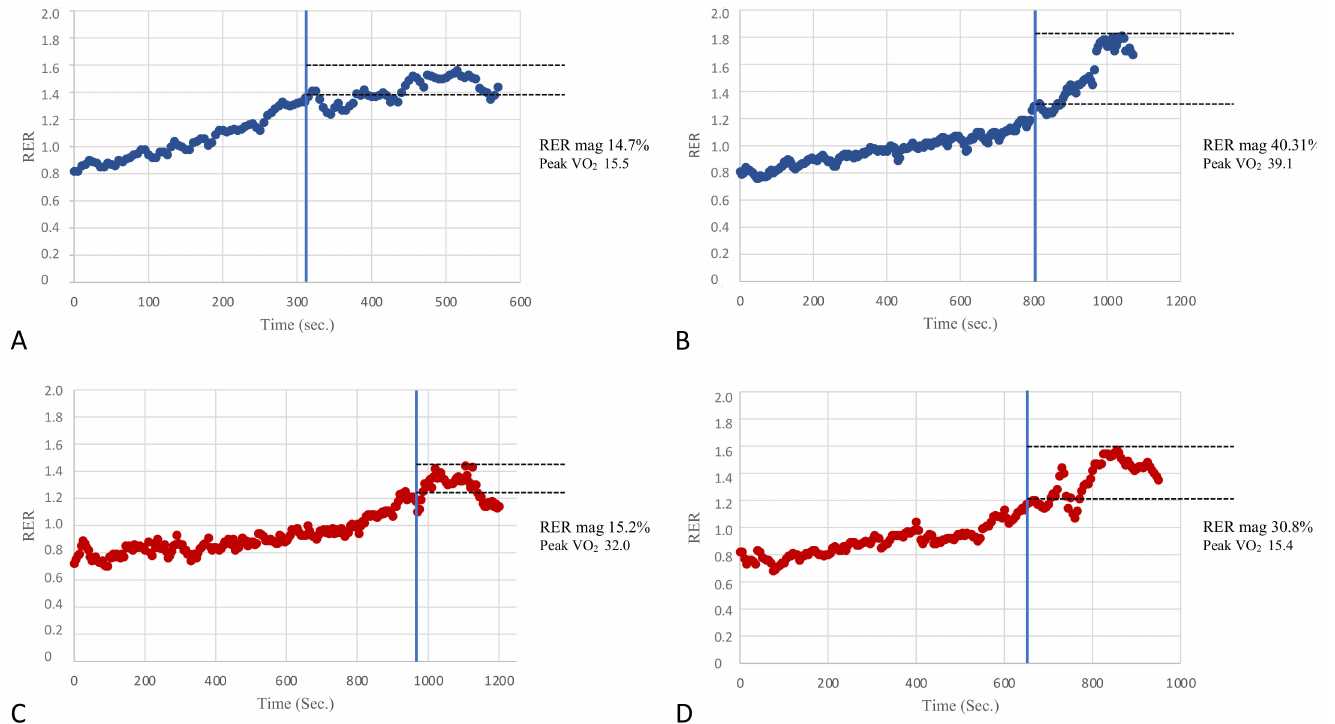
Figure 4. A few visual examples of the RER mag. Panels ( A , B ) show two examples of poor (14.7%) and good (40.31%) RER mag in patients of our population with relatively poor and good cardiovascular fitness as per the peak VO 2 (Weber’s class C and A, respectively). On the other hand, panels ( C , D ) show two examples of a poor (15.2%) and good (30.8%) RER mag in patients with relatively good and poor cardiovascular fitness (Weber’s class A and C, respectively). The RER mag appears to be significantly correlated with cardiorespiratory fitness in the present study; however, this figure suggests that it might also be useful to add the RER overshoot information in the CPET evaluation of patients even in the presence of a normal aerobic capacity and